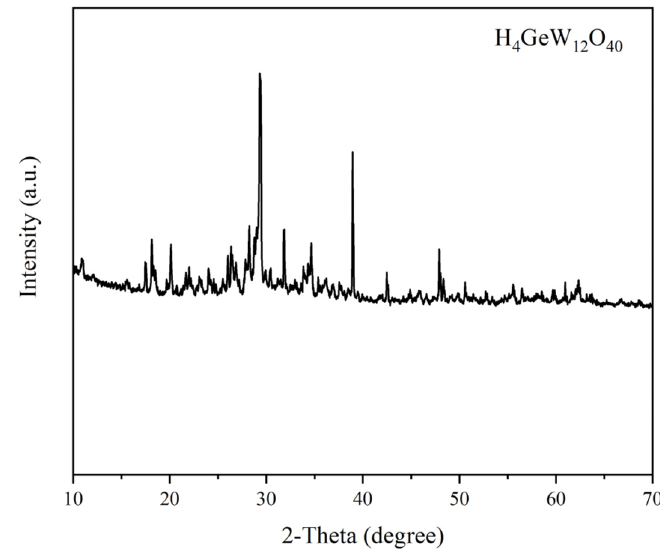
Figure 3. XRD patterns of prepared H 4 GeW 12 O 40 .